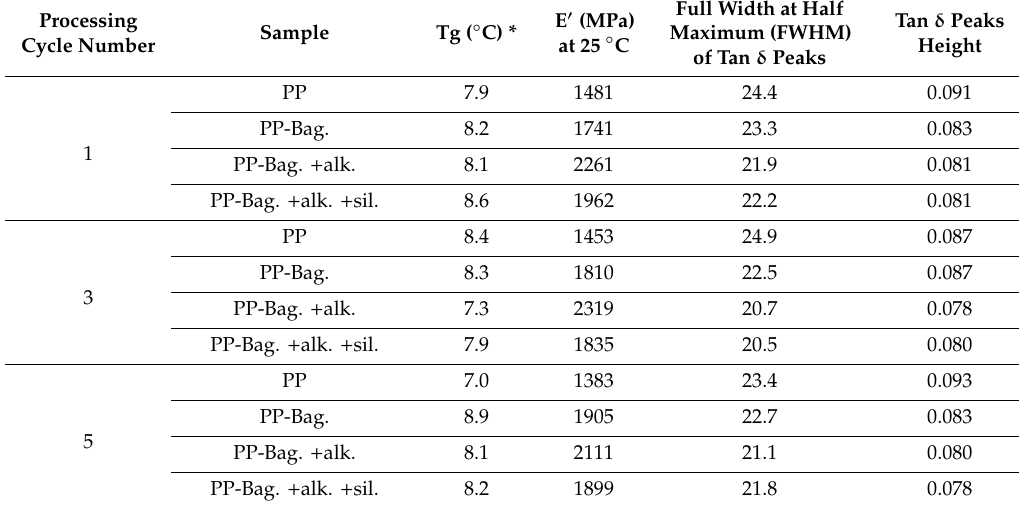
Table 5. Dynamic mechanical analysis (DMA) results of the studied materials. Processing Cycle Number